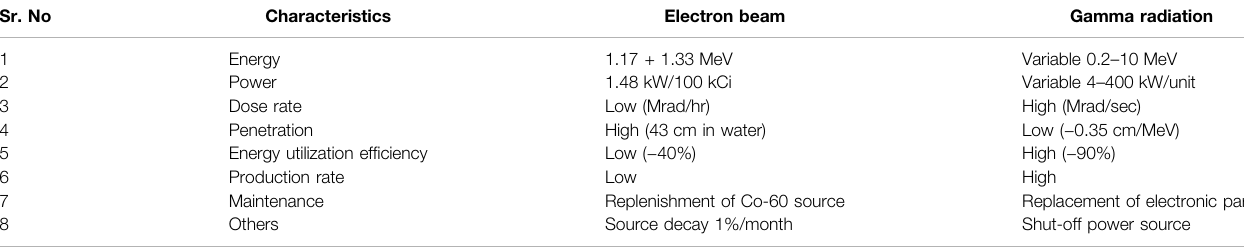
TABLE 1 | Differentiation of gamma radiations and electron beam radiations (Dahlan, 1994).